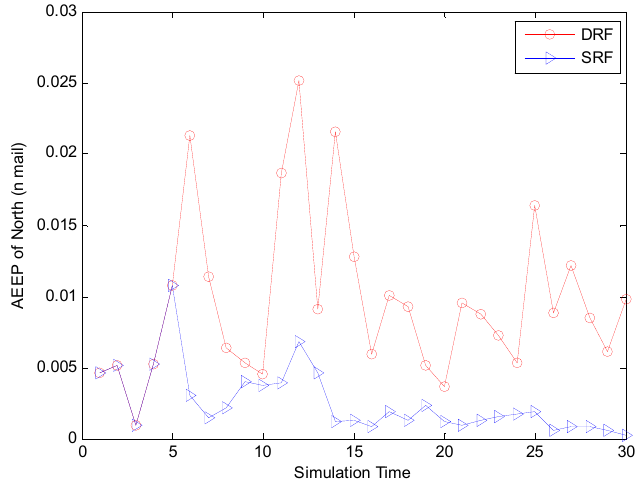
Figure 5. The absolute estimation error of north position.